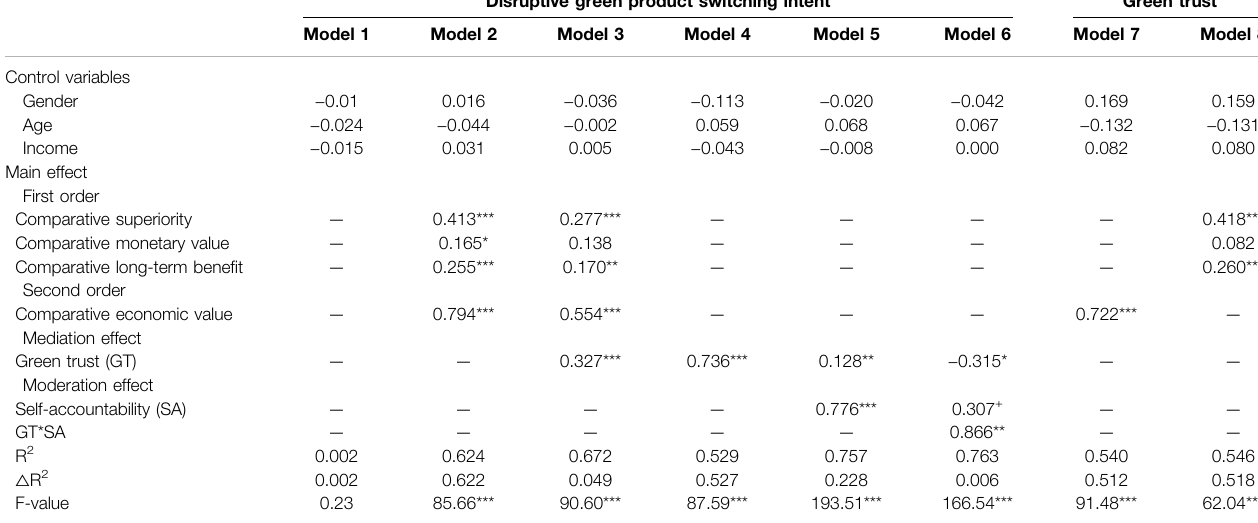
TABLE 5 | Results of hierarchical linear